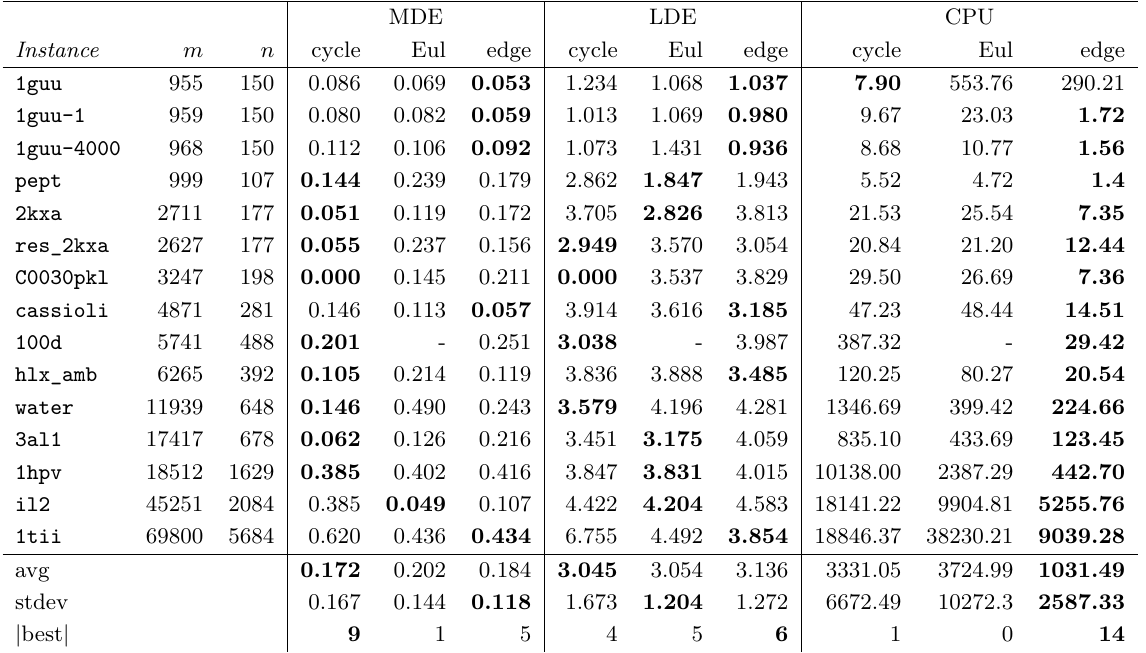
Table 1 Cycle formulation vs. Eulerian relaxation vs. edge formulation performances on protein graphs (realizations in K = 3